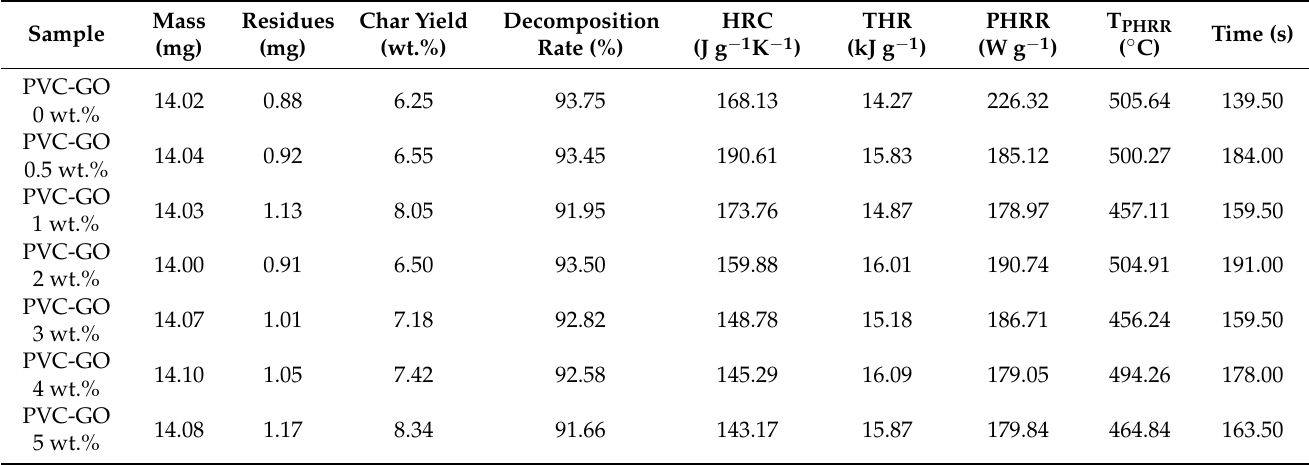
Table 3. Main parameters of microscale combustion calorimetry (MCC) analysis: char yield—percentage quantity of remanent residue, decomposition rate—percentage quantity of sample that was used in the combustion process,